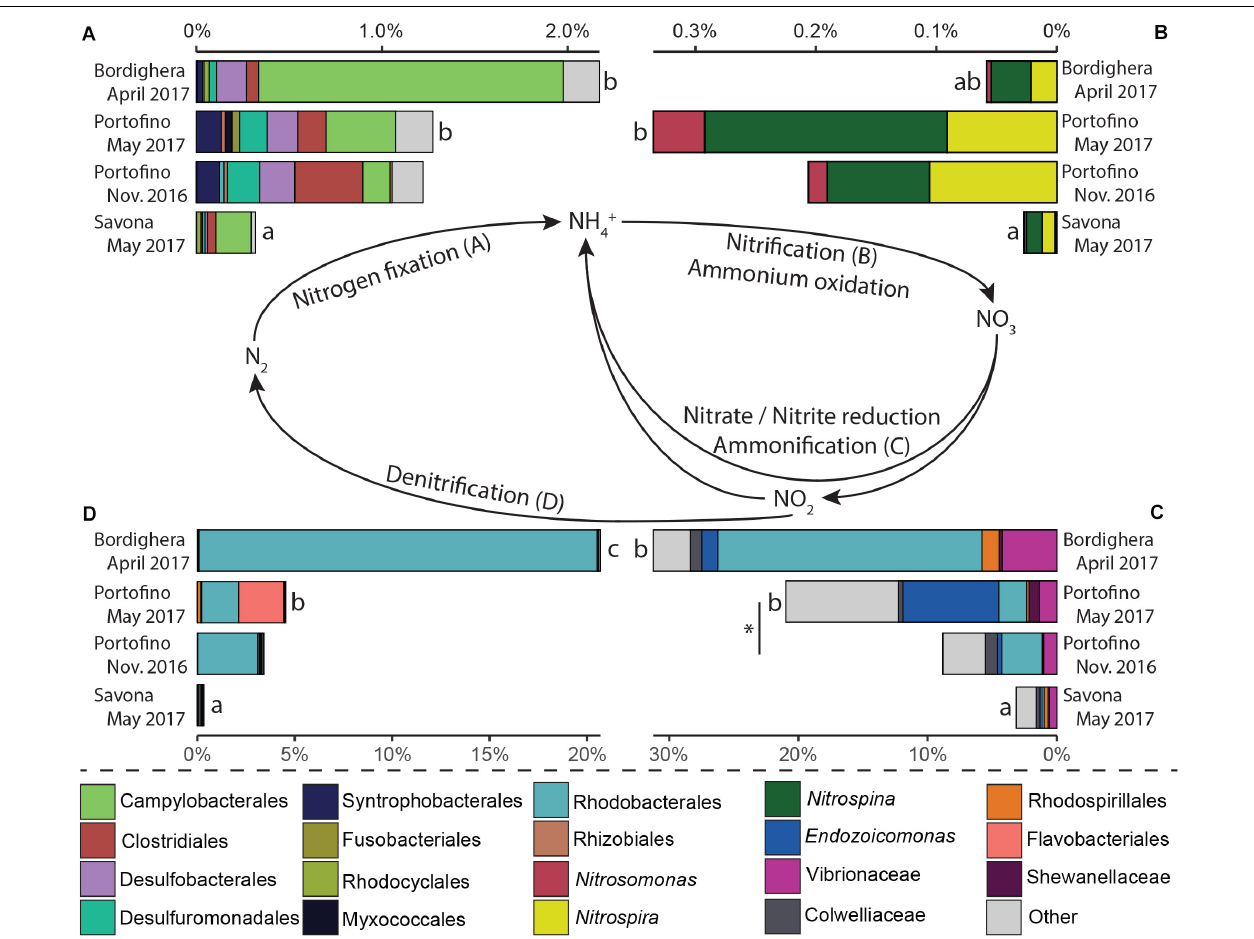
FIGURE 7 | Relative abundance of Antipathella subpinnata- associated bacteria with a putative role in the nitrogen cycle. The nitrogen cycle consists of four main processes and microbes putatively involved in these processes are presented: (A) nitrogen fixation, (B) nitrification/ammonium oxidation, (C) nitrate/nitrite reduction/ammonification and (D) denitrification. Differences between locations are indicated with letters, differences between autumn and spring in the Portofino population are indicated with an asterisk (*). Taxa with low abundances are combined and indicated in light gray.